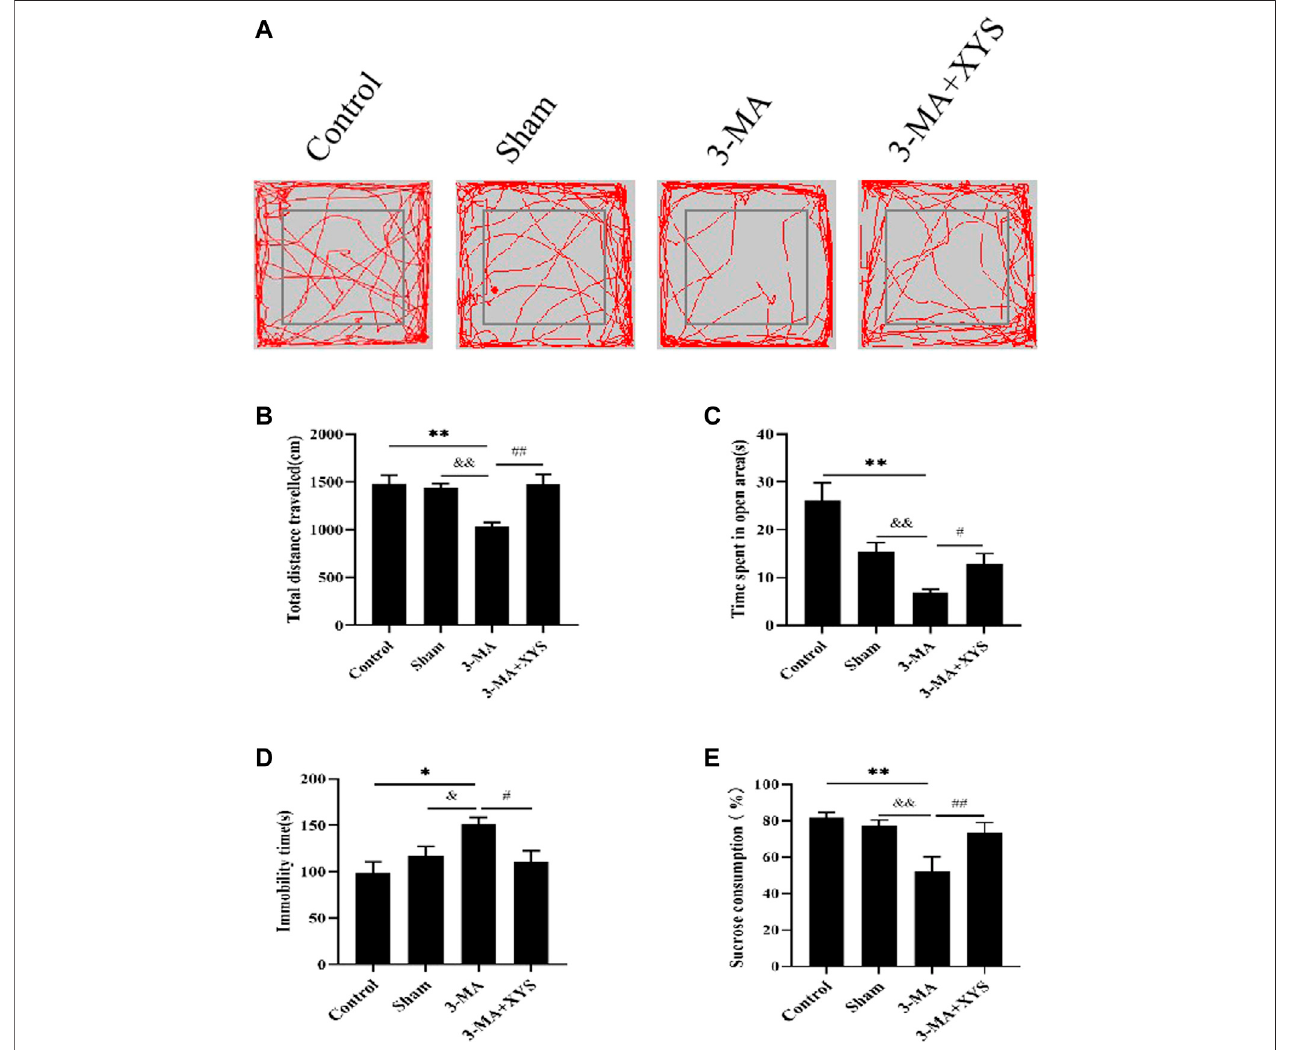
FIGURE7| Xiaoyaosanamelioratedepression-likebehaviorsinmiceInjectedwith3-MA. (A) MapofthetrajectorytakenbymiceineachgroupintheOFTassessed by video tracking software. (B) Total distance traveled in the OFT (F (3, 56) = 8.933, p < 0.0001, n = 15). (C) Time spent in open area in the OFT (F (3, 56) = 11.767, p < 0.0001,n=15). (D) Immobilitytime spent intheTST(F(3, 56)=4.534, p =0.0065,n=15). (E) SucroseconsumptionintheSPT(F(3,56)=29.444, p < 0.0001,n=15). Thevaluesshownrepresentthemean±SEM.Thevaluesrepresentthemean±SEM. p p < 0.05or pp p < 0.01comparedwiththecontrolgroup.& p < 0.05,& p < 0.01 compared with the 3-MA group. # p < 0.05, ## p < 0.01 compared with the 3-MA group.